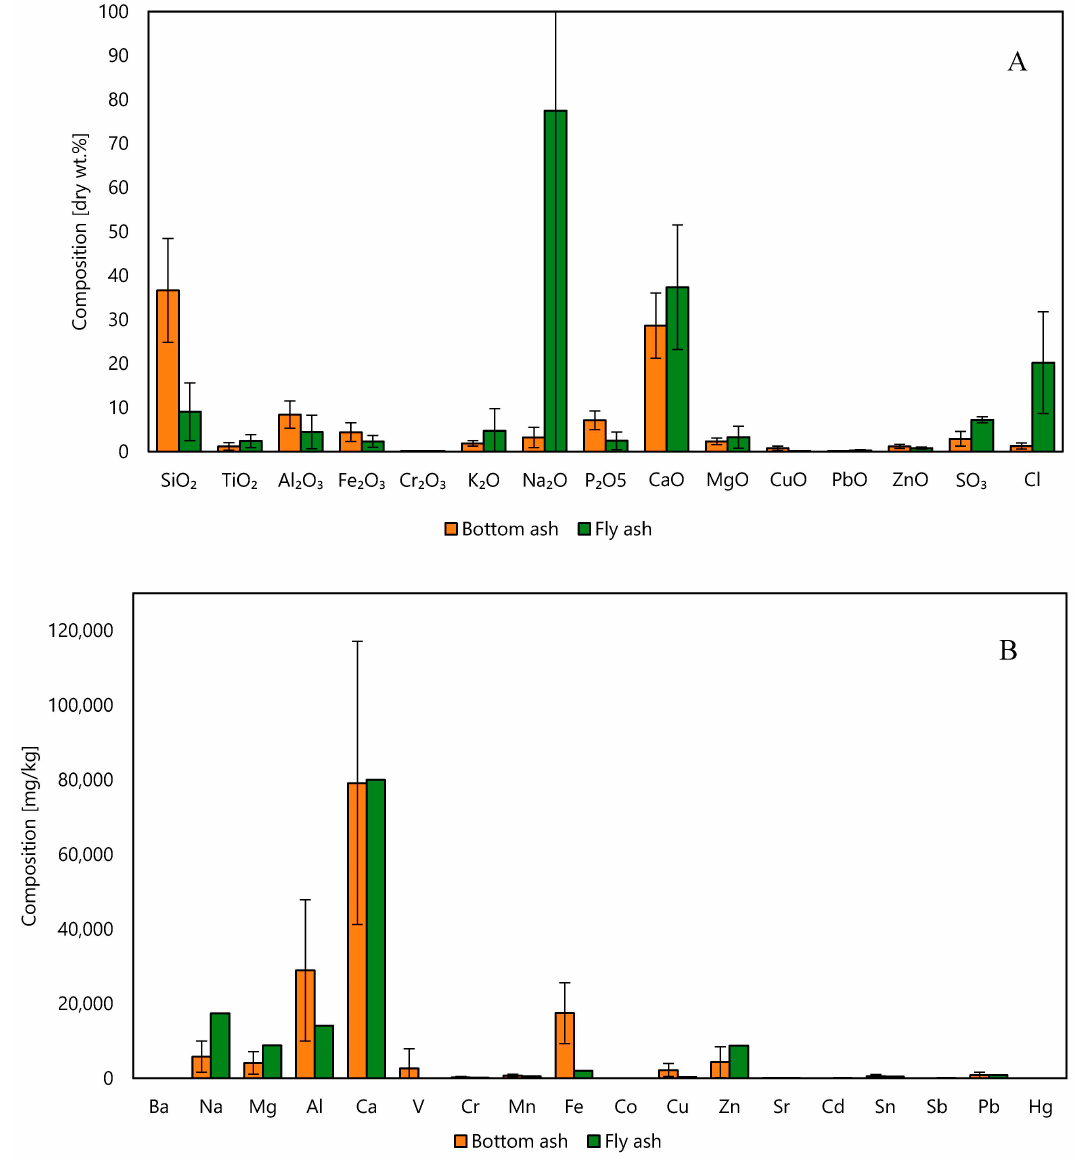
Figure 5. Composition of bottom and fly ash [45]: ( A ) minerals and ( B ) metals .